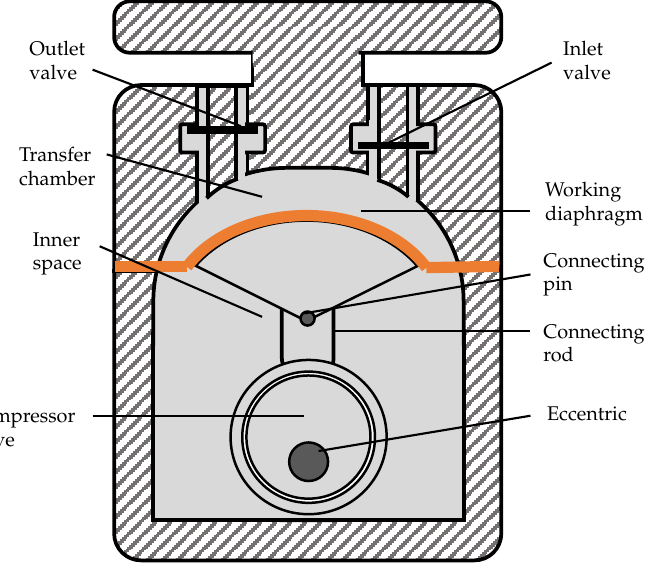
Figure 1. The section view of a diaphragm compressor cylinder/compression compartment, with the details of the internal component.